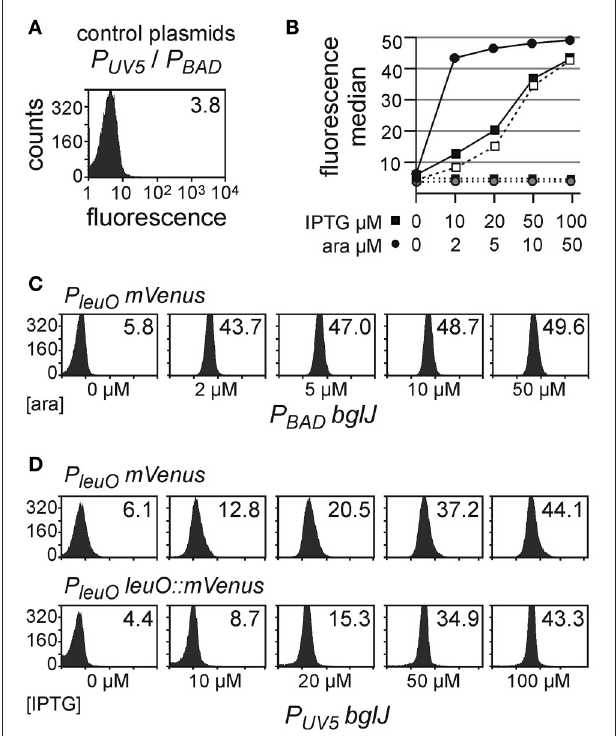
FIGURE 2 | Activation of leuO transcription by BglJ. Expression of P leuO mVenus (in strain U69) and P leuO leuO::mVenus (strain U97) transcriptional fusions was determined by flow cytometry in absence and presence of the transcriptional activator BglJ, which was provided by plasmids. Expression was analyzed after 5h of growth in tryptone medium without and with indicated inducer concentrations at an optical density OD 600 of approximately 0.7–1. (A) Fluorescence intensity directed by P leuO mVenus in individual cells of transformants of strain U69 with the empty vectors pKETS24 ( P UV 5 in pSC- ori ) and pBAD30 ( P BAD in p15A- ori ). Yellow fluorescence (X-axis) is given in arbitrary units and the Y-axis gives the number of cells that were counted. The median of the fluorescence intensity is given in the upper right corner of the graph. (B) Plot of the median fluorescence values that are shown in (C) (solid line with filled dots) and (D) (solid line with filled squares P leuO mVenus and dashed line with open squares P leuO leuO::mVenus ). In addition, median fluorescence values of transformants of vector controls are shown (pKETS24, P UV 5 as dotted line and filled squares, and pBAD30, P BAD dotted line with gray dots). (C) Fluorescence intensity of transformants of strain U69 with plasmids pKES302 ( P BAD bglJ in p15A- ori ) and pKETS24 ( P UV 5 in pSC- ori ). The arabinose concentration used for induction of bglJ expression is given underneath the panels. (D) Fluorescence intensity of transformants of strain U69 ( P leuO mVenus ) with plasmids pKETS26 ( P UV 5 bglJ in pSC- ori ) and pBAD30 ( P BAD in p15A- ori ), as well as of strain U97 ( P leuO leuO::mVenus ). The IPTG concentration used for induction of bglJ expression is given underneath the panels. Shown are representative data.